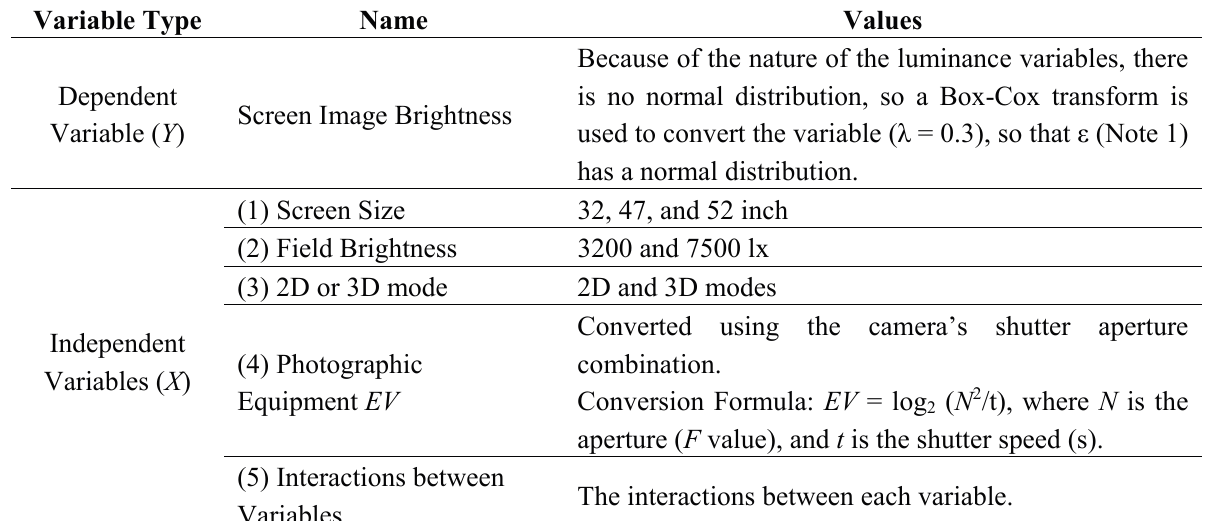
Table 3. Dependent and independent variables.